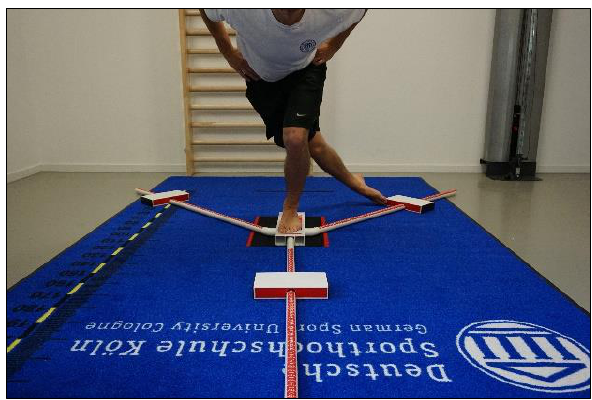
Figure 1. The Y-balance test